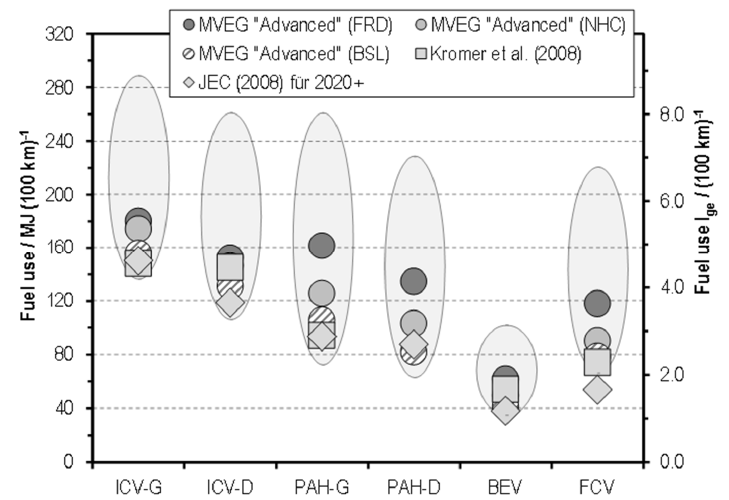
Figure 8. Comparison of results with data from the literature. The range of values accord to the fuel economy calculations for the scenario, “advanced”. Selected values apply for the MVEG drive cycle considering the cases, “Frost day” (FRD), “No heating & cooling” (NHC) and “Base load only” (BSL). For definitions, see Table 10. Values from the literature correspond to JEC [8] in the configuration “2010+” and Kromer et al. [7] for the timeframe 2030.